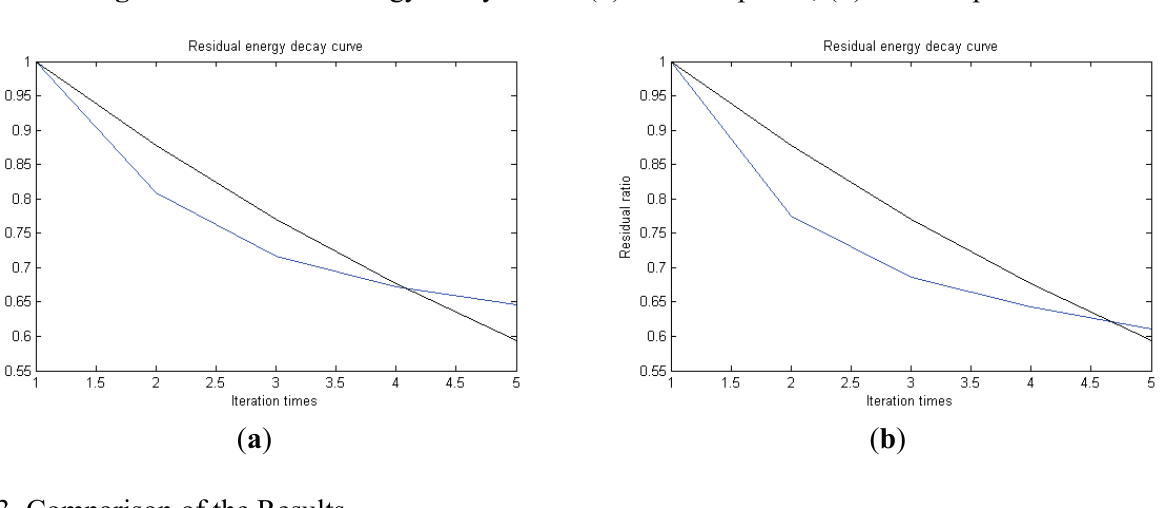
Figure 24. Residual energy decay curve: ( a ) first 512 points; ( b ) last 512 points.